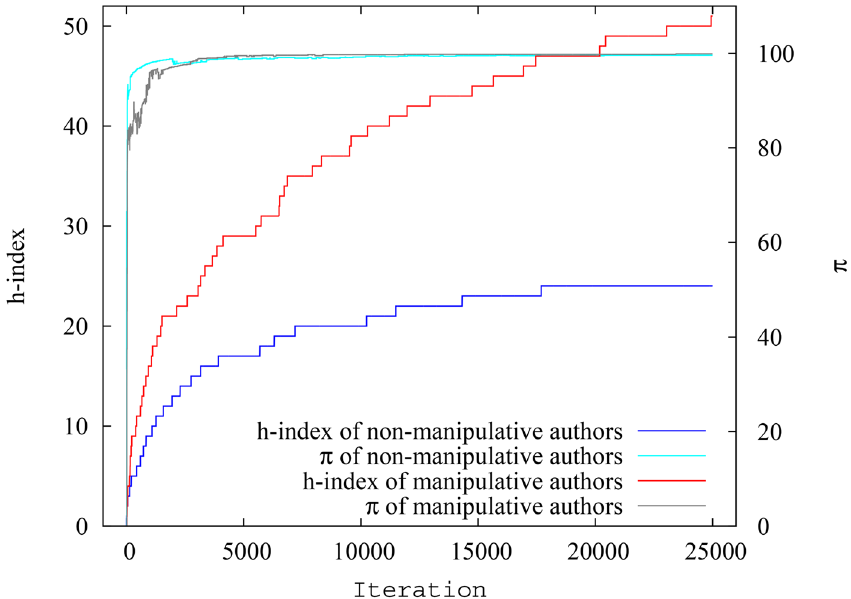
Fig 6. Variation of h-index and pagerank-index for highest ranking non-manipulative and manipulative authors at each timestep for simulation scenario 1.